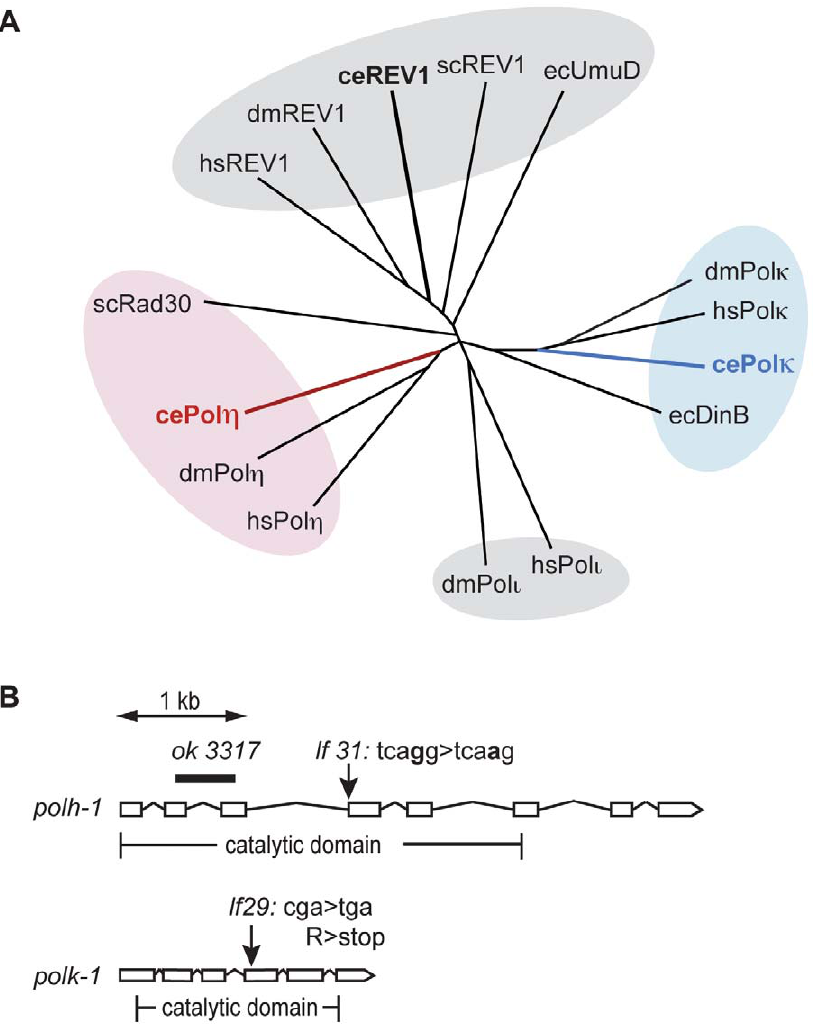
Figure 1. Y-family polymerases POLH-1 and POLK-1 of C.elegans . (A) Phylogenetic tree displaying Y-family polymerases from C. elegans, S. cerevisiae, D. melanogaster, E. coli and H. sapiens . Respectively red and blue branches show C. elegans POLH-1 (Pol g ) and POLK-1 (Pol k ). (B) Gene structure of the C. elegans polh-1 and polk-1 genes and the molecular nature of the alleles used in this study.